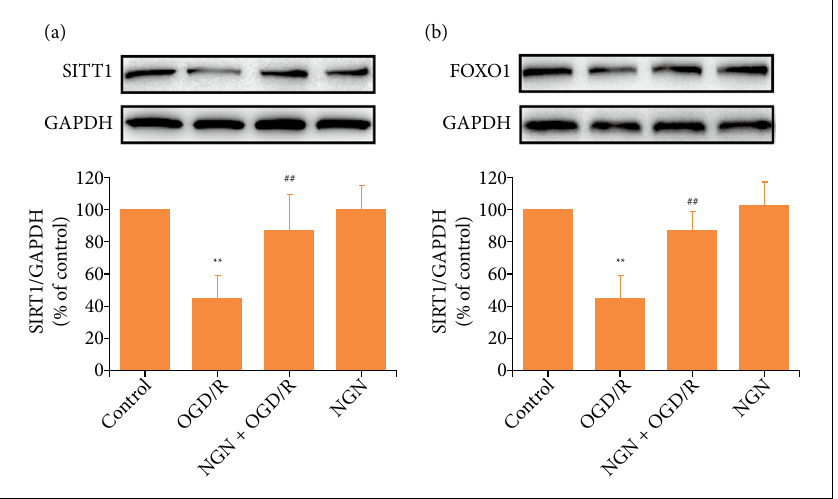
Figure 3 – Effects of naringenin on SIRT1/FOXO1 signaling pathway in OGD/R-exposed HT22 cells. HT22 cells were treated with naringenin (80 μ mol·L –1 ) for 2 h followed by treatment with OGD (6 h)/R (24 h). (A) SIRT1 and (B) FOXO1 expressions were detected by western blot analysis. Data were expressed as mean ± SD from 3-4 independent experiments. ** P < 0.01 vs. control group; ## P < 0.01 vs. OGD/R group. NGN: naringenin; OGD/R: oxygen-glucose